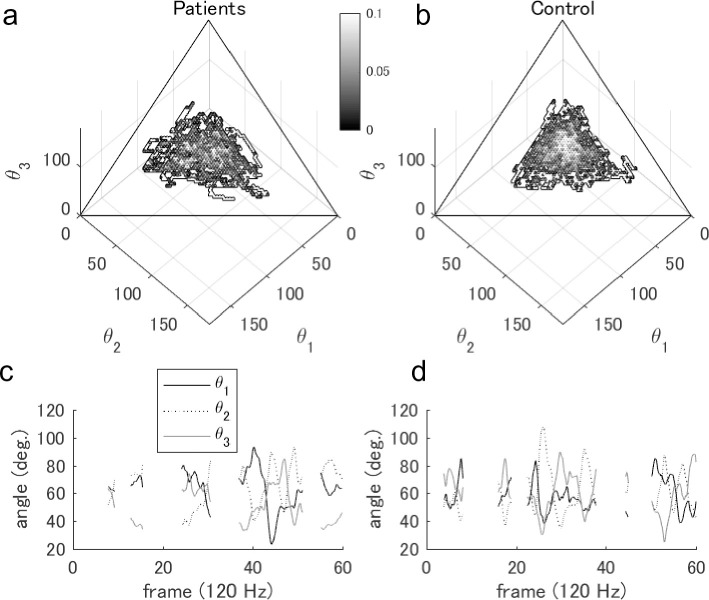
Comparison of group coordination between two groups.Grayscale contour plots in (a) the patients and (b) the control group indicate the normalized frequency in a three-angle space. The three angles indicate inner angles in the triangle of three attackers (see in Materials and Methods); thus, the plot was on the (two-dimensional) phase plane. The typical time series of the three angles in (c) the patients and (d) the control group are shown.